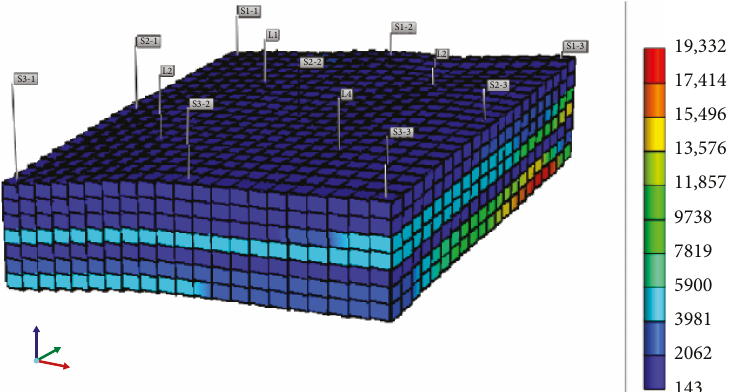
Figure 5: The distribution diagram of initial